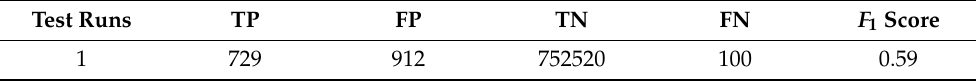
Table 11. BusyBox Similarity, Excluding Small